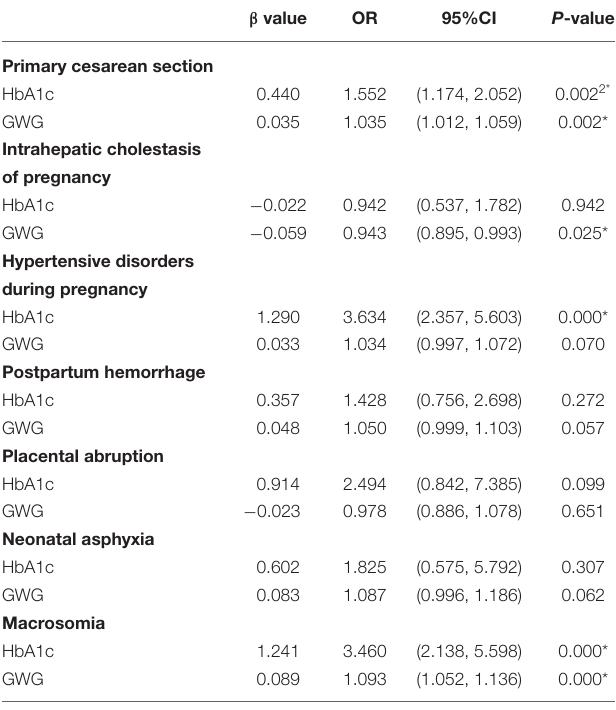
Post-partum Placental Hypertensive hemorrhage disorders during pregnancy